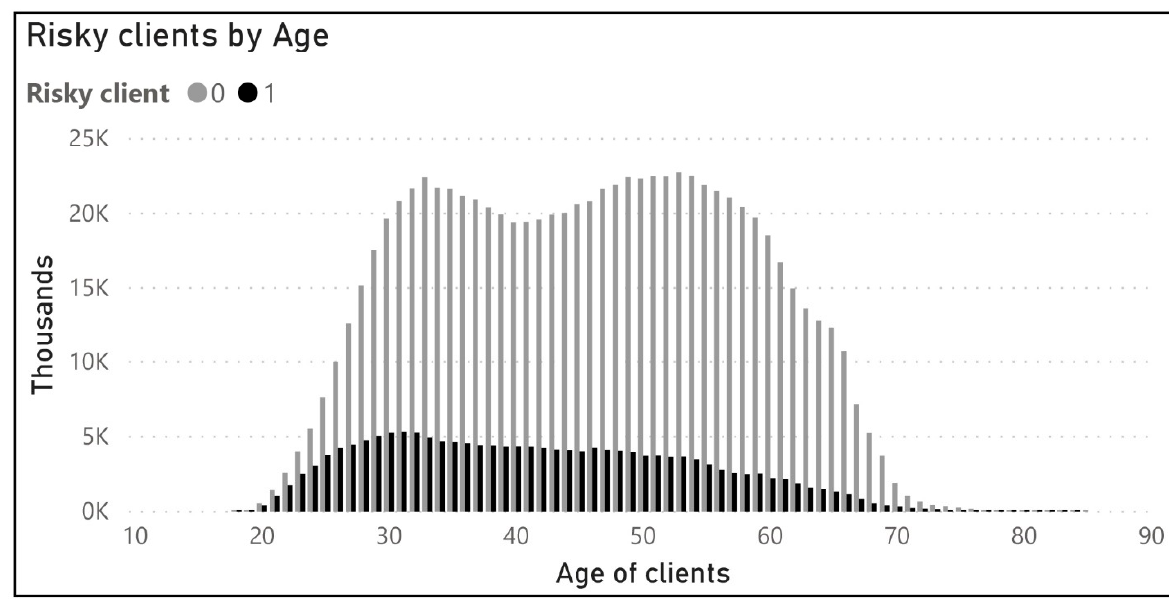
Figure 3. Risk by age (represented as years on X -axis) and by duration of loans. The figure shows that more risky borrowers (with black) are around age 32 years, and that the number of loans is bigger in around age 32 and around 55 (with gray).